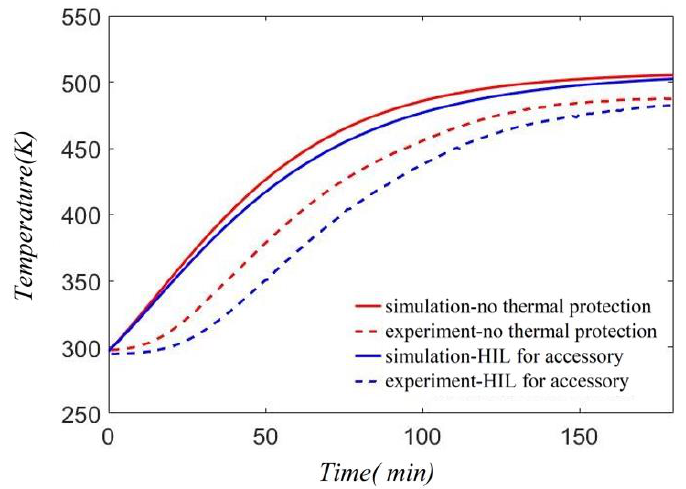
Figure 9. Comparisons between the experimental results and the numerical results for an accessory in the turbine engine .